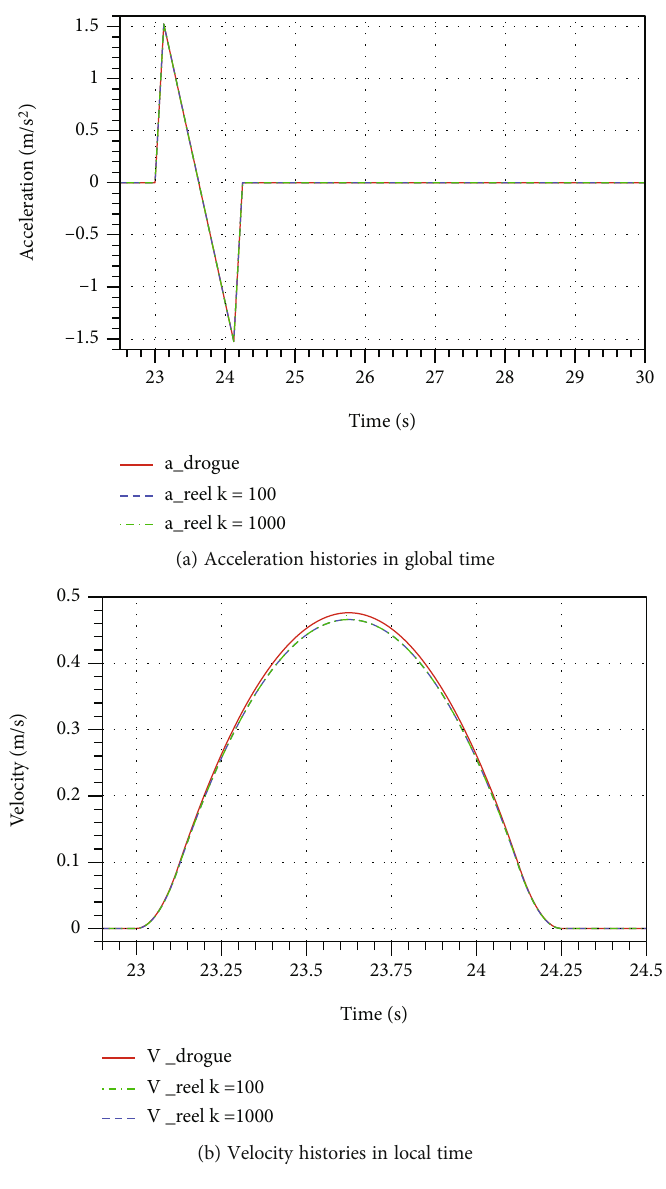
Figure 9: Case W2E0-k acceleration and velocity histories with di ff erent k